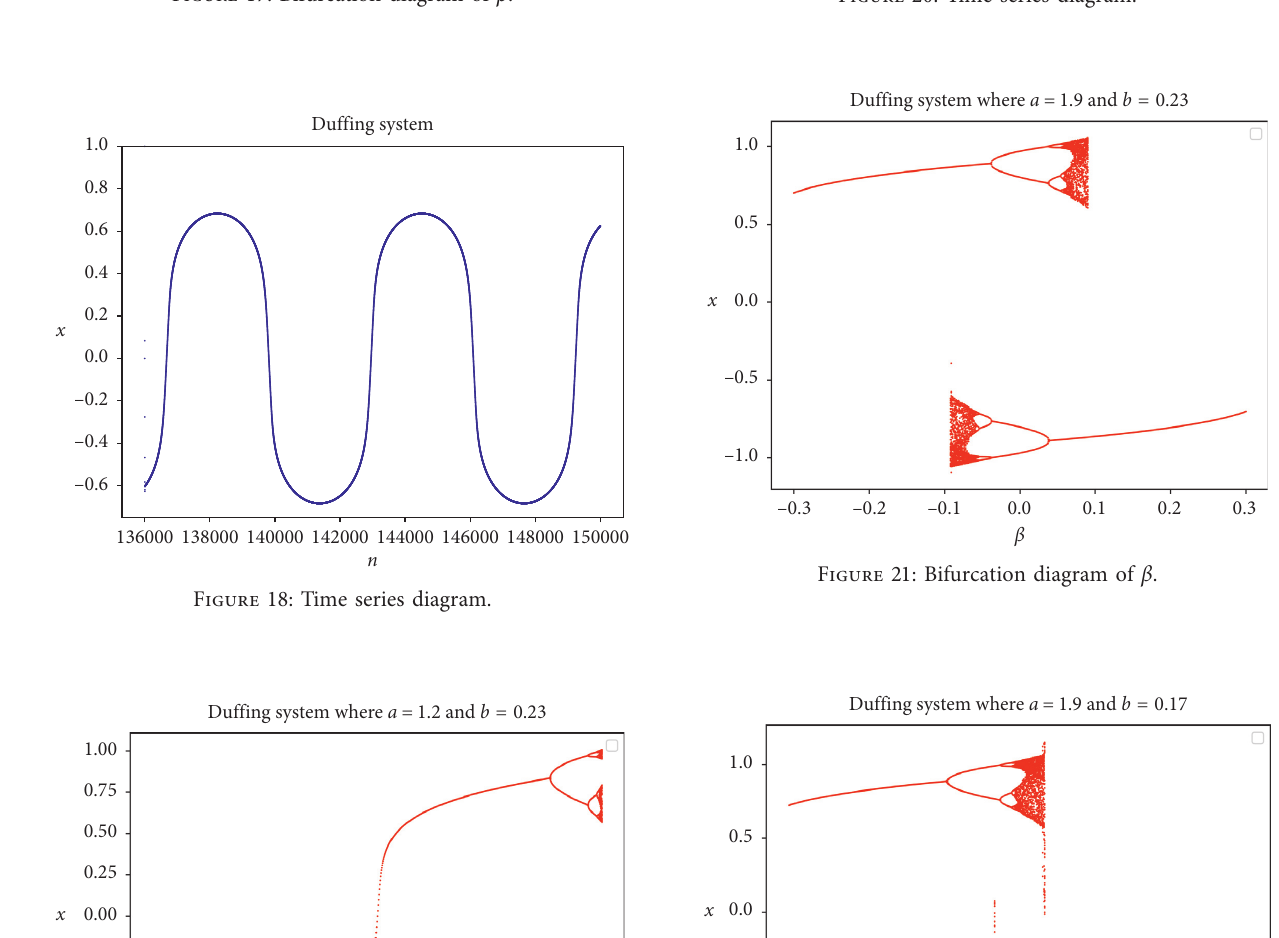
Figure 17: Bifurcation diagram of β .